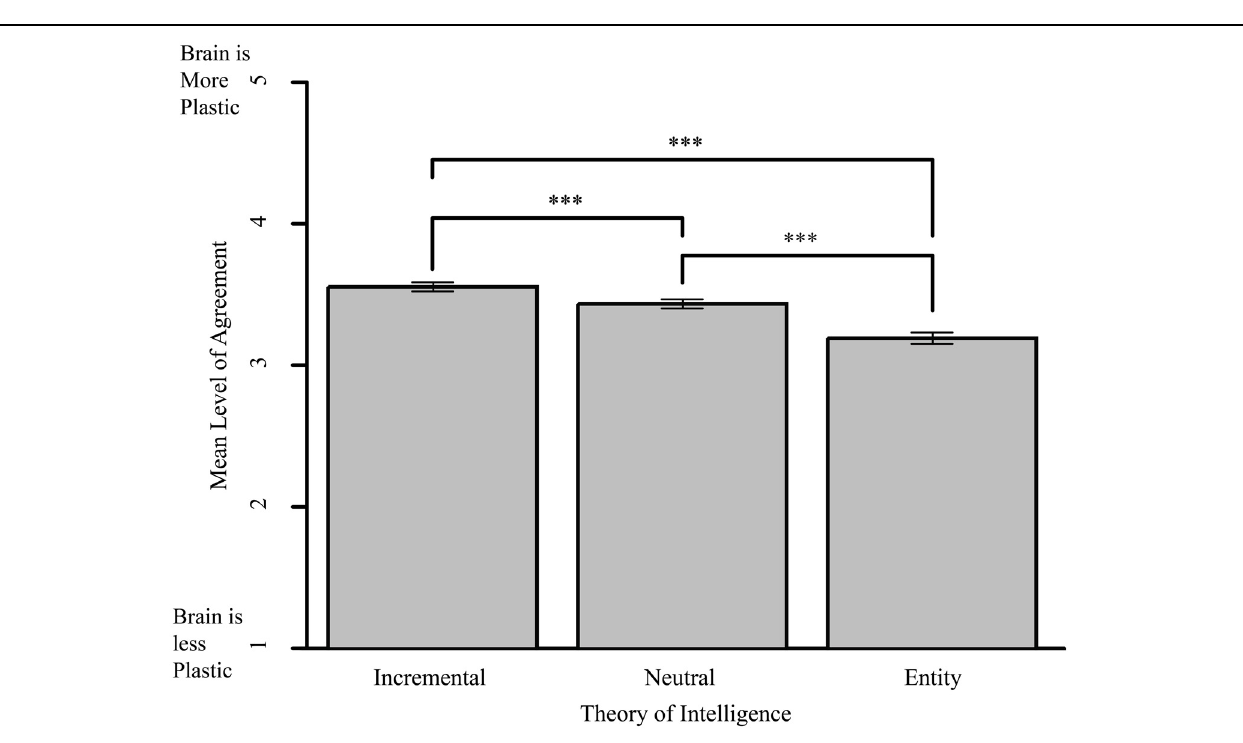
Frontiers in Psychology | www.frontiersin.org